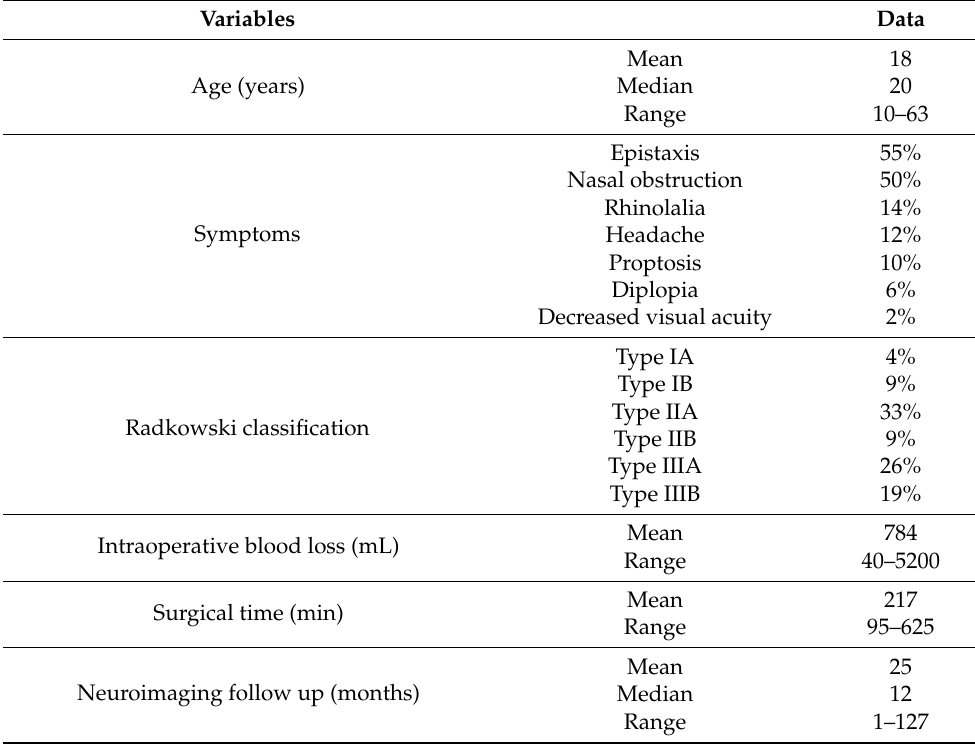
Table 1. Demographic, clinical and procedural characteristics of the 79